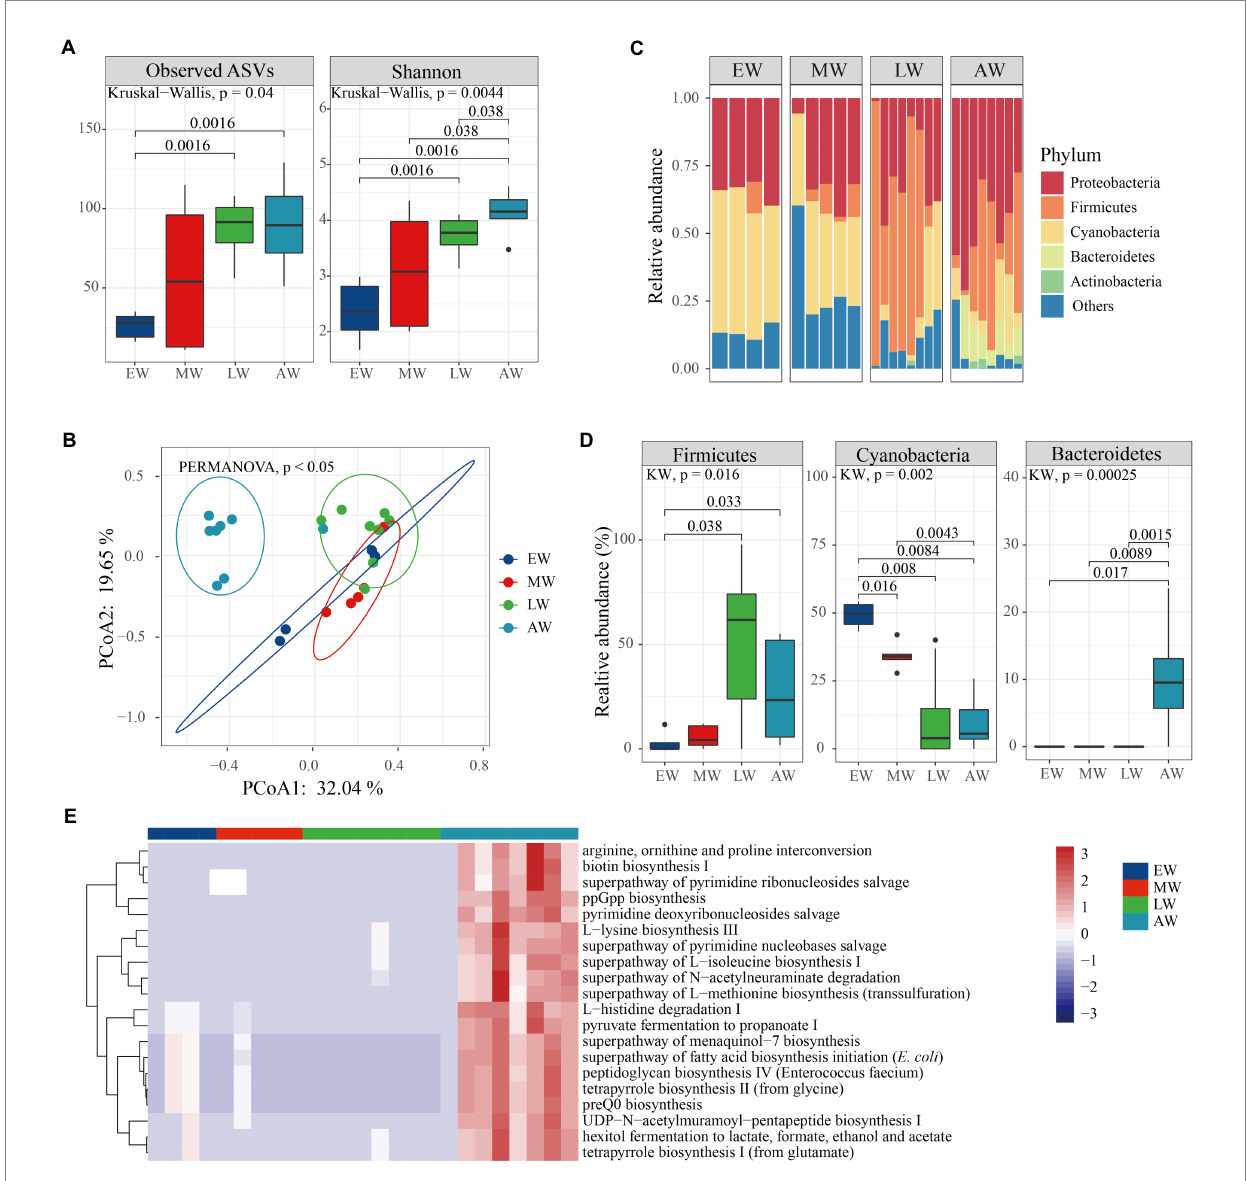
FIGURE 4 The variation of microbial diversity between the four stages of workers in Bombus terrestris . (A) Alpha diversity (ASVs and Shannon indices) of microbiota in worker bumble bees using Kruskal–Wallis test. (B) PCoA plot based on Bray–Curtis distance metrics depicting the differences in microbial community structure (ES represents early larvae stage, MS represents mid larvae stage, LS represents late larvae stage. AS represents adult stage). (C) Phylum-level microbial composition of bumble bees. (D) The relative abundance of phyla significantly differed between the four groups (Kruskal–Wallis test, p < 0.05). (E) The relative abundance of the top 20 metabolic pathways using PICRUSt-predicted Metacyc